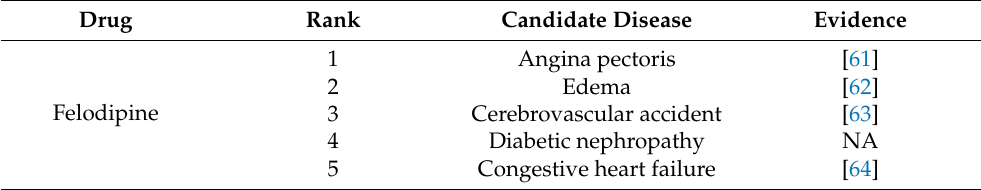
Table 5. Top 10 related drugs for Parkinson’s disease predicted by EMPHCN. Disease Rank Candidate Drug Evidence 1 Pergolide [54] 2 Metixene [30] 3 Orphenadrine [56] 4 Galantamine [55] 5 Donepezil [57] Parkinson’s disease 6 Cabergoline [58] 7 Cyclobenzaprine [59] 8 Gabapentin [60] 9 Dantrolene NA 10 Mephentermine NA